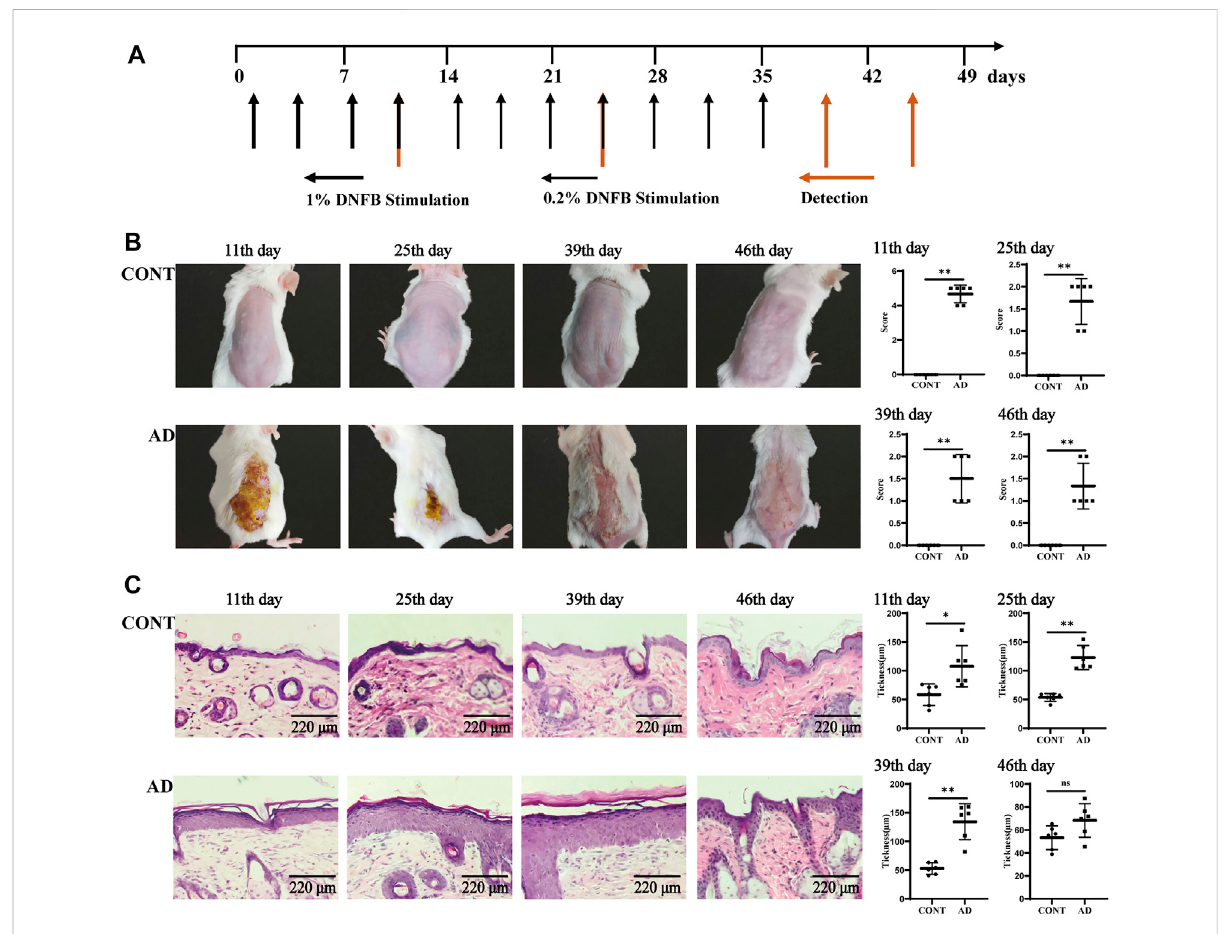
FIGURE 1 Experimental fl owchartandskinobservation. (A) Time fl owchartofDNFBstimulationanddetection.Themorphologyandfunctionsoftheskin and hippocampus and behavioral experiments, such as OFT and TST, were operated on the 11th, 25th, 39th, and 46th day after primary stimulation. (B) Back skin performance and the skin lesion scores in mice at different times (because of the long fur hair, the shaving operation was carried out again before the 39th and 46th day, and the speci fi c shaving operation was the same as before). (C) Skin histology and epidermal thickness in mice at different times. All data are presented as mean ± SD; n = 6 mice/group. * p < 0.05, ** p < 0.01 vs. the CONT group. CONT, normal mice; AD, DNFB-treated